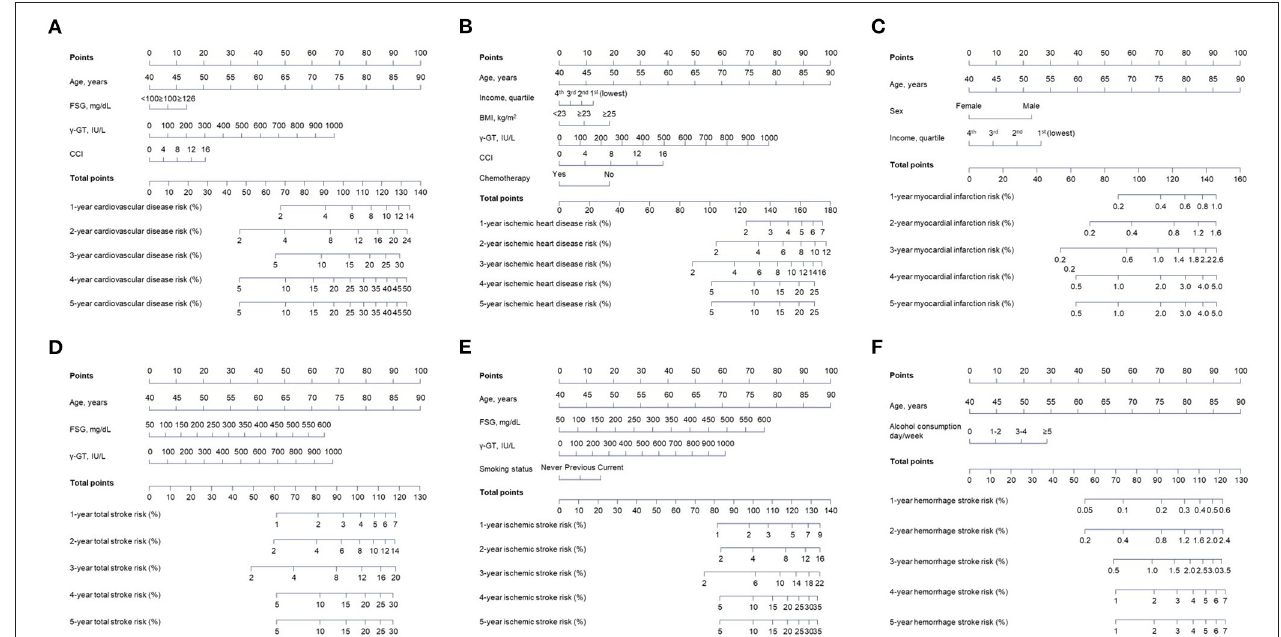
FIGURE 2 | Derivation of the nomograms based on the identified independent risk factors for each cardiovascular disease subtype from the training cohort. An individualized evaluation was carried out by drawing straight vertical lines up to the assigned point for each risk factor. Corresponding risk probabilities are directly estimated by drawing a straight vertical line from the corresponding total point down to cardiovascular risk probabilities. (A) Overall cardiovascular disease nomogram. (B) Ischemic heart disease nomogram. (C) Myocardial infarction nomogram. (D) Total stroke nomogram. (E) Ischemic stroke nomogram. (F) Hemorrhage stroke